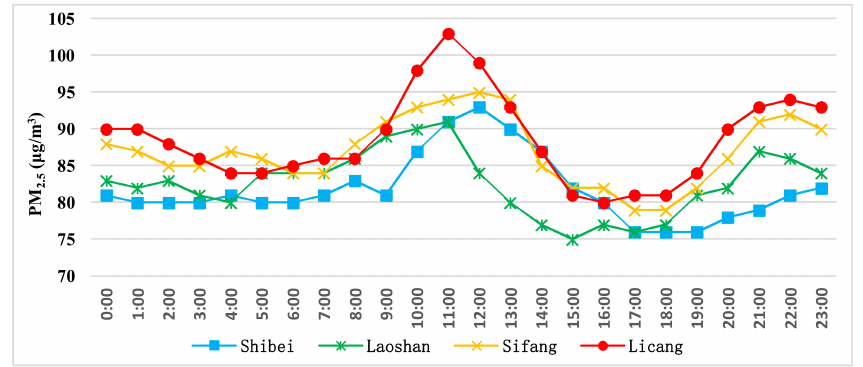
Figure 7. Chart of diel variation of concentration of PM 2.5 by hour in winter.